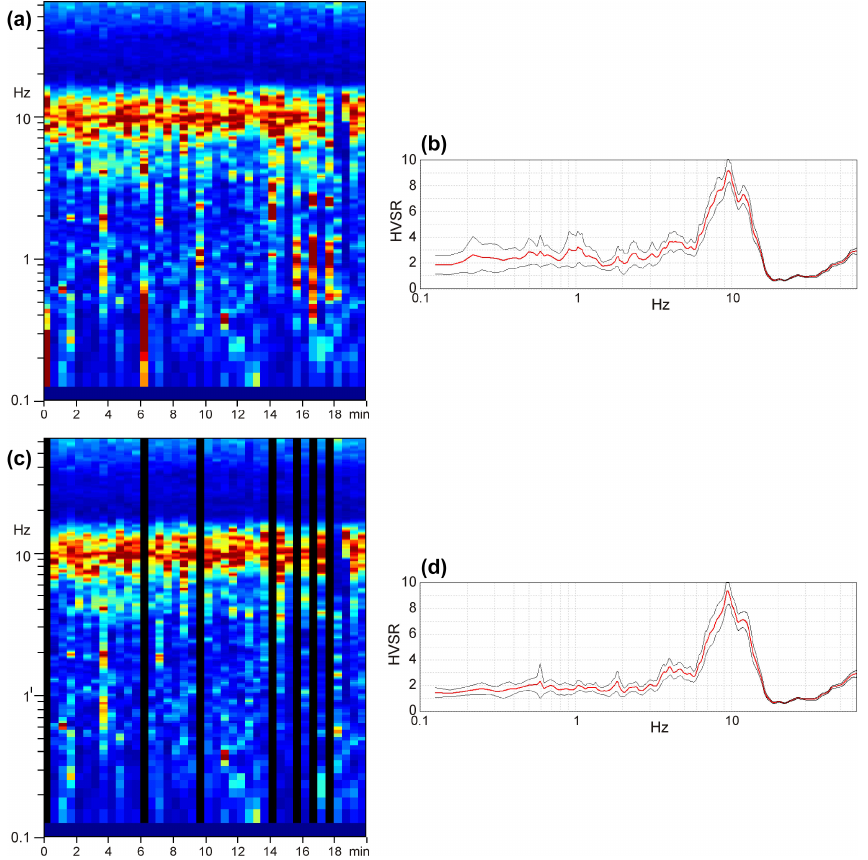
Figure 4. (a) Stability of the H / V spectral ratio within 20min long record at point Id3 analyzed in 30s long windows. (b) Corresponding average HVSR curve for all windows. (c) Removal of several noisy windows from the record resulted in (d) better signal-to-noise ratio in HVSR